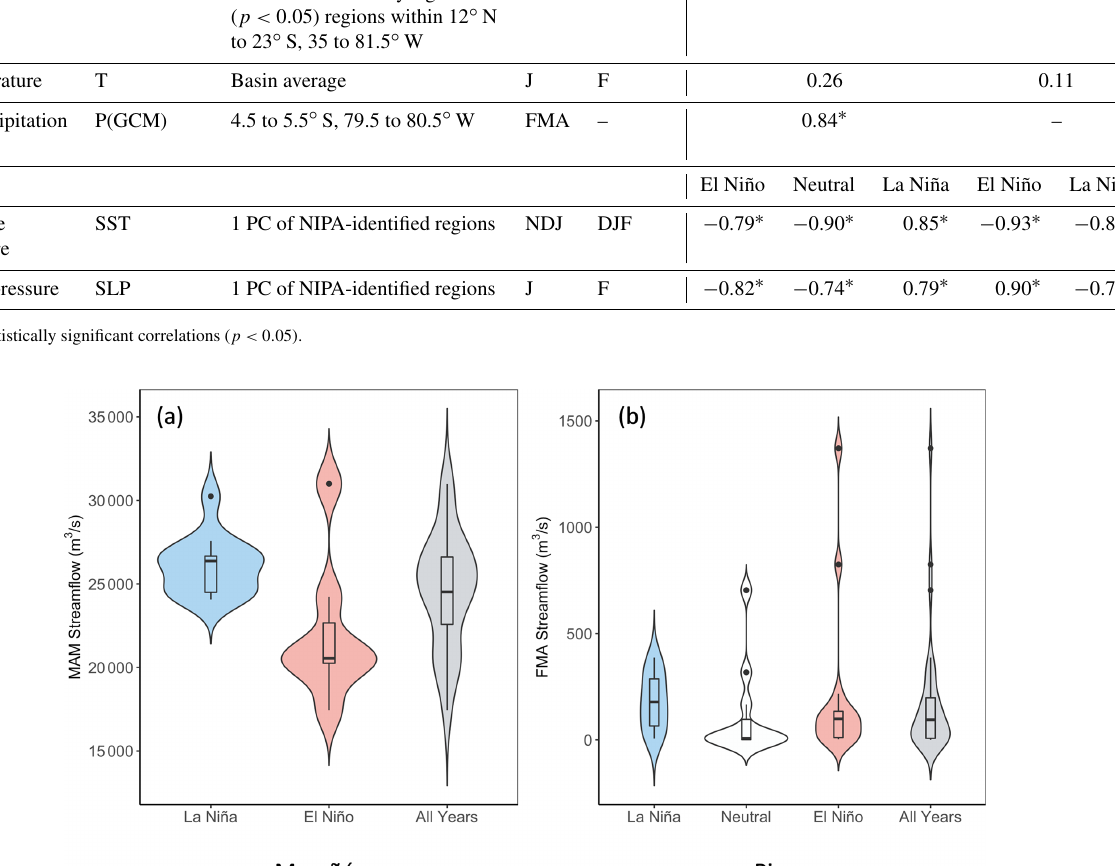
sented by the preseason (3-month average) value of